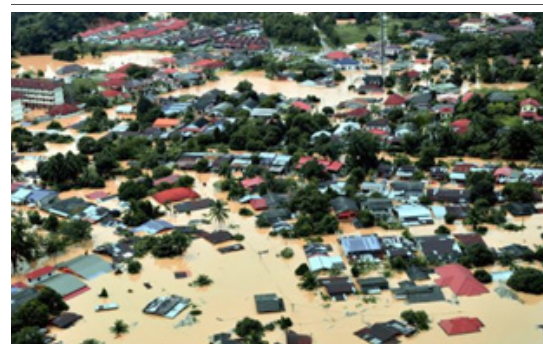
Figure 1. A Flooded Village in the Kuala Krai Distinct, State of Kelantan,